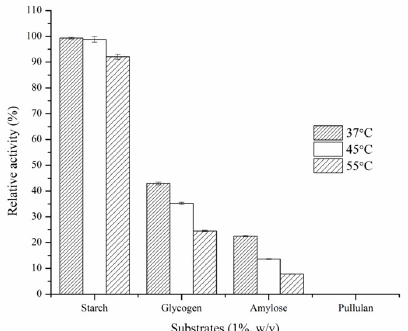
Fig. 5. Substrate specificity of the purified amylase of Bacillus amyloliquefaciens MCCB0075 and thermal stability on different temperatures (37-55°C). Relative activity was defined as the percentage of maximum activity detected in the assay. Values are mean ± SE of three independent experiments